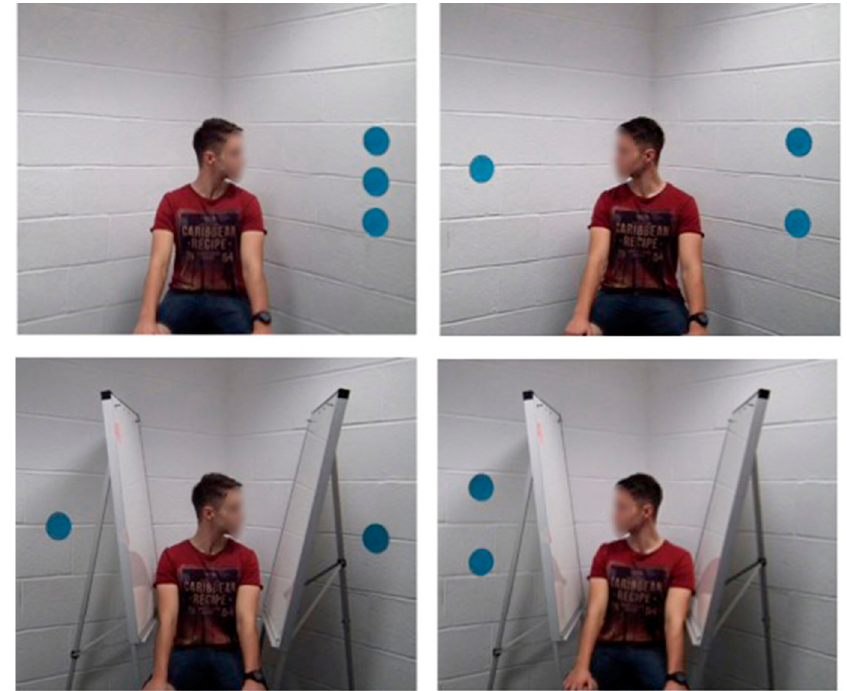
Figure 1. Examples of the stimuli used in Experiment 1. The top row depicts images in the seeing condition with different arrangements of three target discs. The bottom row contains examples of stimuli in the non-seeing condition with different arrangements of two target discs. The face of the gazer was not blurred in the actual experiment.